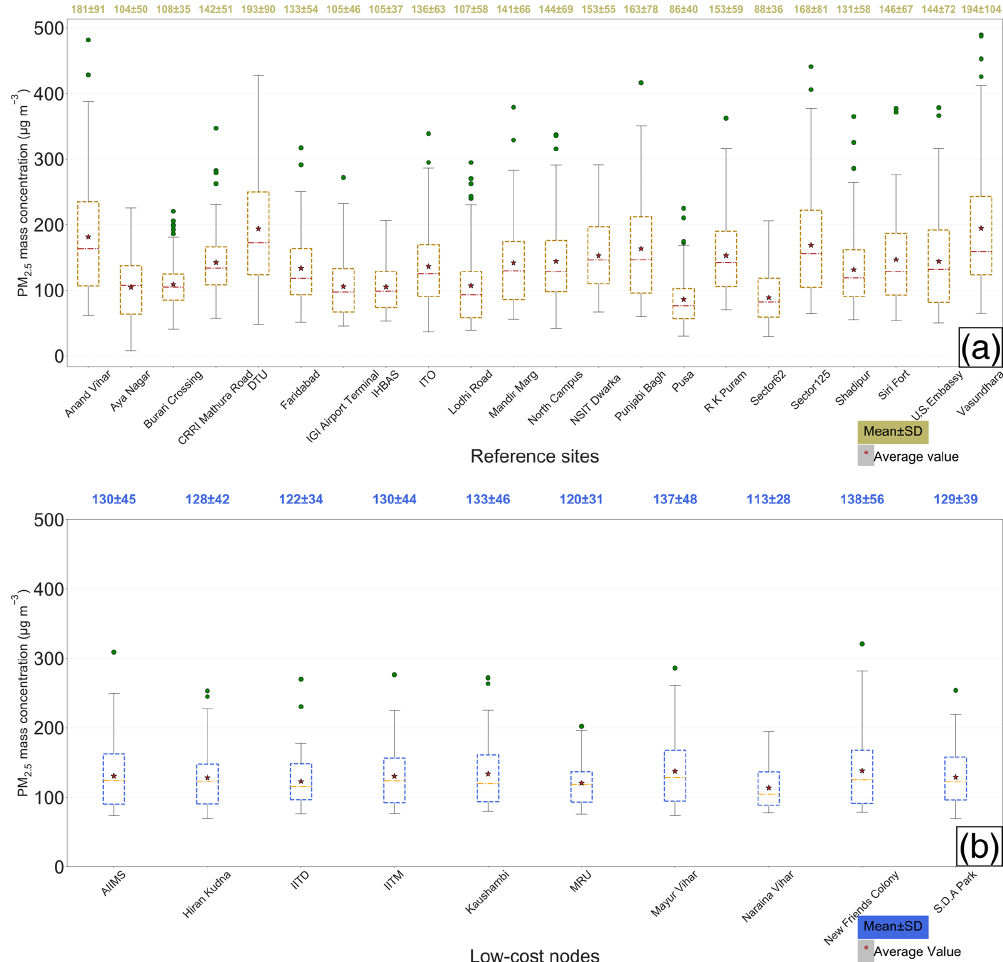
Figure 4. (a) Box plots of the 24h aggregated true ambient PM 2 . 5 mass concentrations measured by the 22 government reference monitors across Delhi from 1 January to 31 March 2018. (b) Box plots of the low-cost node 24h aggregated PM 2 . 5 mass concentrations calibrated by the optimized GPR model. In both (a) and (b) , mean and SD of the PM 2 . 5 mass concentrations for each individual site are superimposed on the box